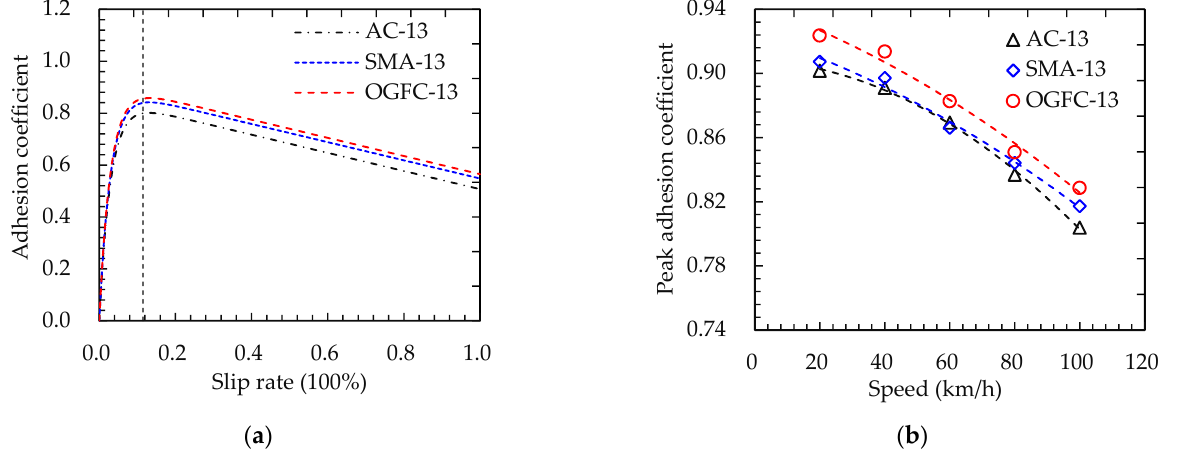
Figure 12. Peak adhesion coefficient curves of asphalt pavement: ( a ) adhesion coefficient varied with slip rate; ( b ) peak adhesion coefficient.